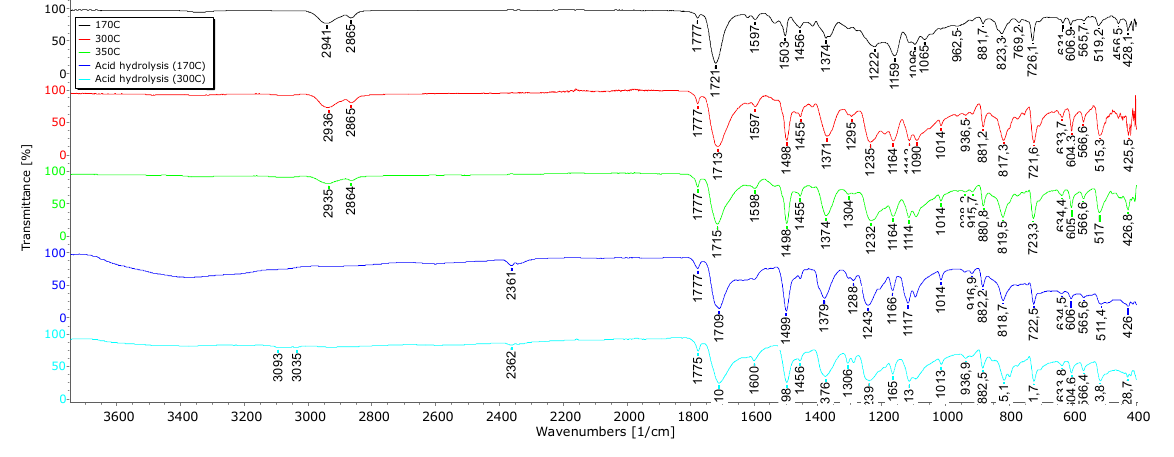
Figure 5. IR spectrum of the copoly(urethane-imide) film thermalized at 170 °C (black curve) for 30 min; film samples thermalized for 30 min: at 300 °C (red curve) and at 350 °C (green curve); film samples soaked in a mixture of concentrated hydrochloric acid (90% vol) and acetic acid (10% vol) for 24 h after heating for 30 min: at 170 °C (blue curve) and 300 °C (turquoise curve).